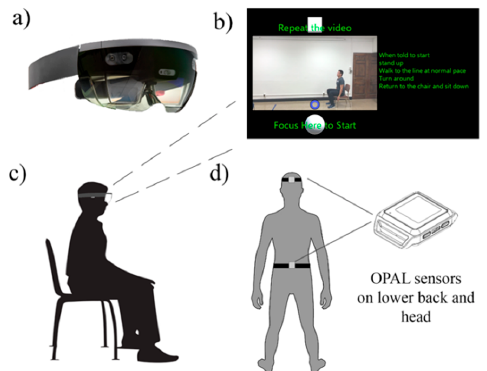
Figure 1. Illustration of the system setup. ( a ) HoloLens headset; ( b ) Onscreen hologram instruction for the timed up and go test (Shaded background, video animation, green font, white control button and purple gaze cursor); ( c ) Illustration of the participant’s starting position; and ( d ) Reference IMU sensors placement.